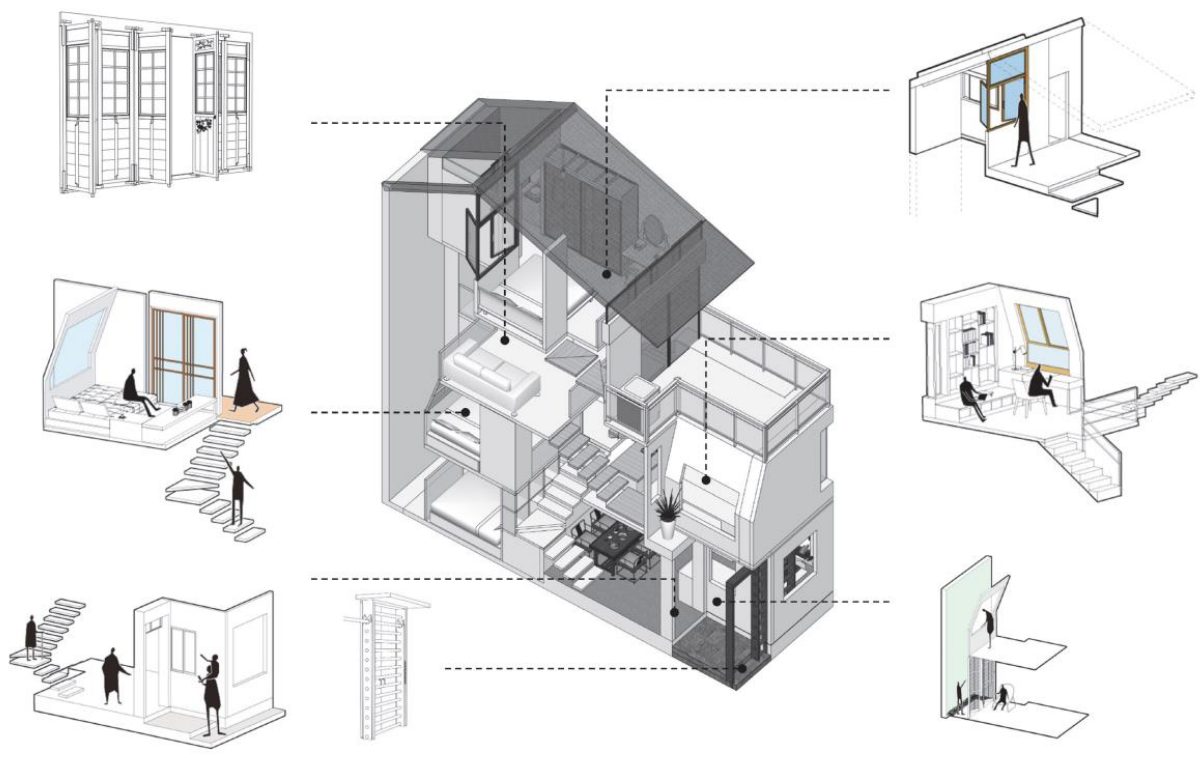
Figure 21. Typical space and construction maintenance diagram for a concept design (drawn by the students).